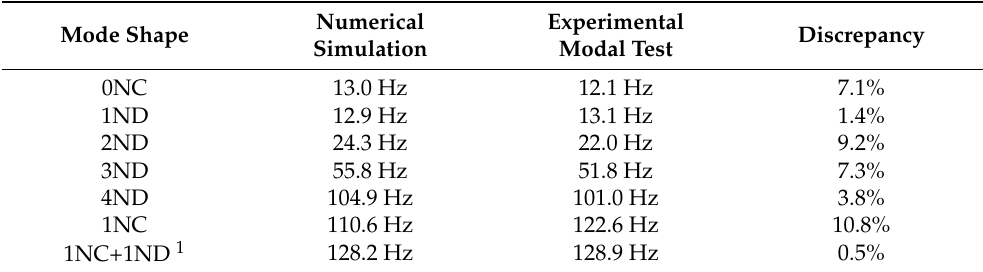
Table 2. Natural frequencies obtained from numerical and experimental modal analyses of the non-rotating disk in water.